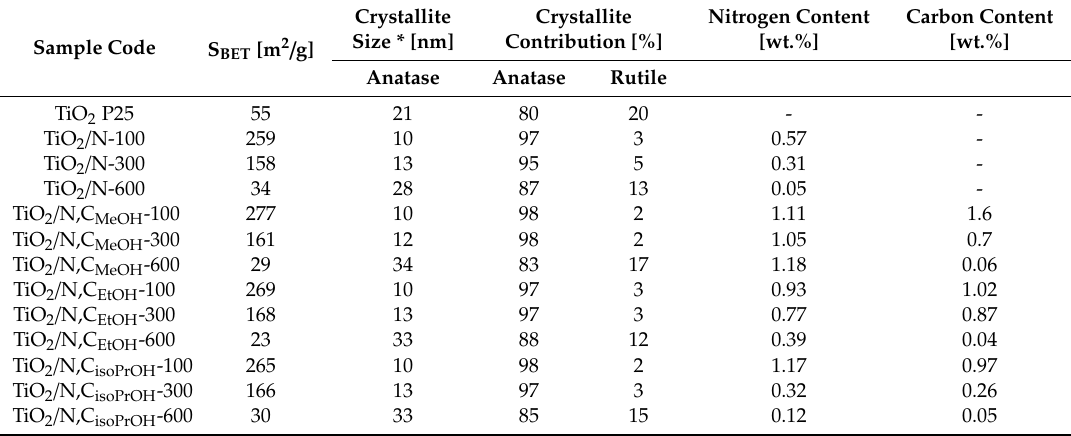
Table 1. Physicochemical characteristic of reference TiO 2 P25 and modified TiO 2